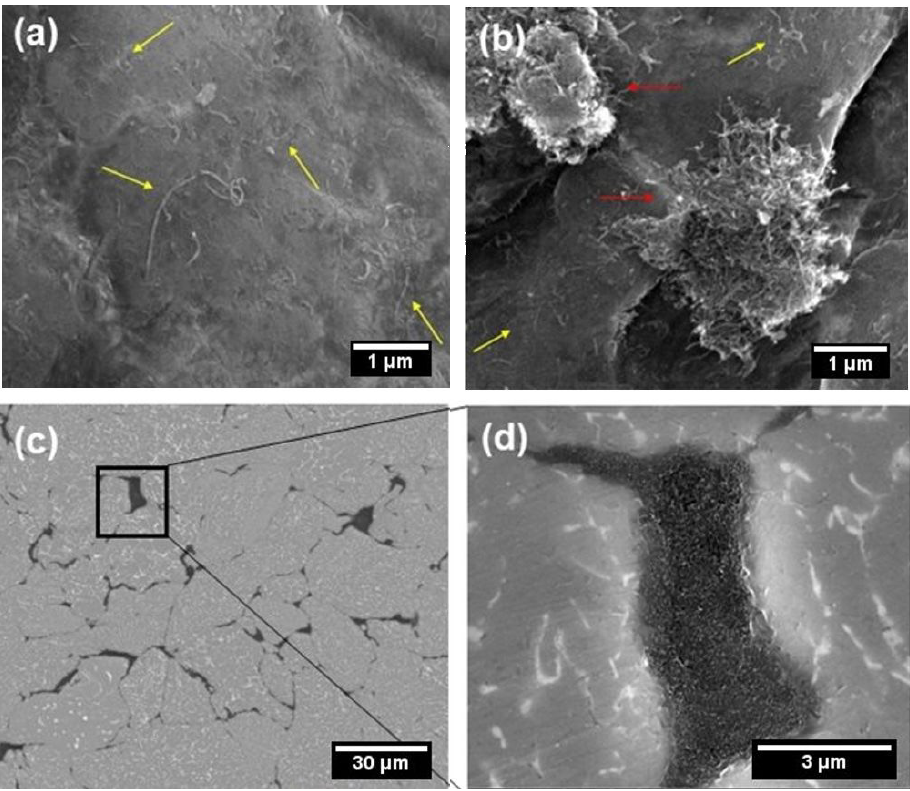
Figure 2. SEM images of Composite A (0.5 wt.% MWCNT/AA7050): (a) powders with dispersed MWCNT (yellow arrows); (b) MWCNT clusters (red arrows); (c) hot extruded material; and (d) detail of a MWCNT